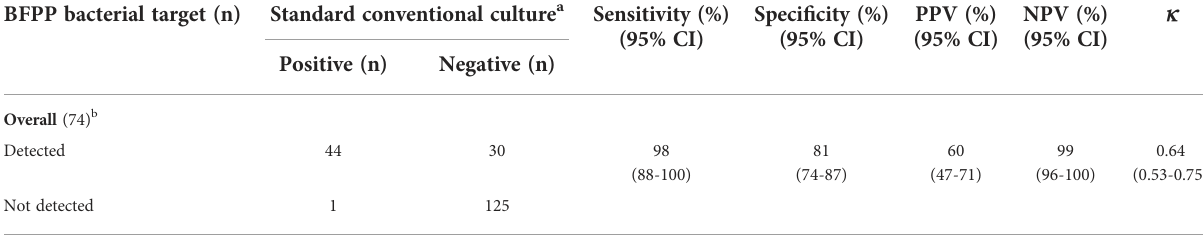
TABLE 5 Overall sensitivity, speci fi city, positive predictive value, negative predictive value, and Cohen ’ s Kappa coef fi cient ( k ) of BioFire FilmArray Pneumonia Panel Plus assay to detect all identi fi ed etiologies of hospital-acquired pneumonia and ventilator-associated pneumonia. BFPP bacterial target